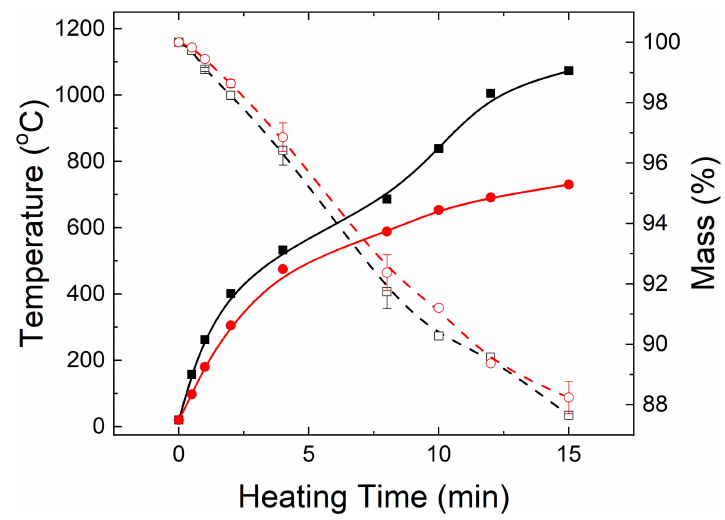
Figure 2. Temperature (solid markers) and mass loss (open markers) as a function of microwave heating time for Pipe ( , □) and OK (●, ○ ) ores.